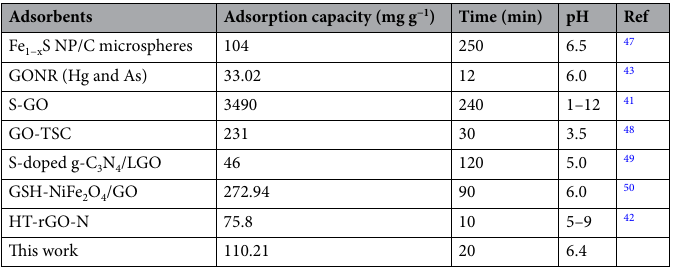
Table 1. Comparative maximum adsorption capacity, time, and pH of several adsorbents for the Hg(II) removal.